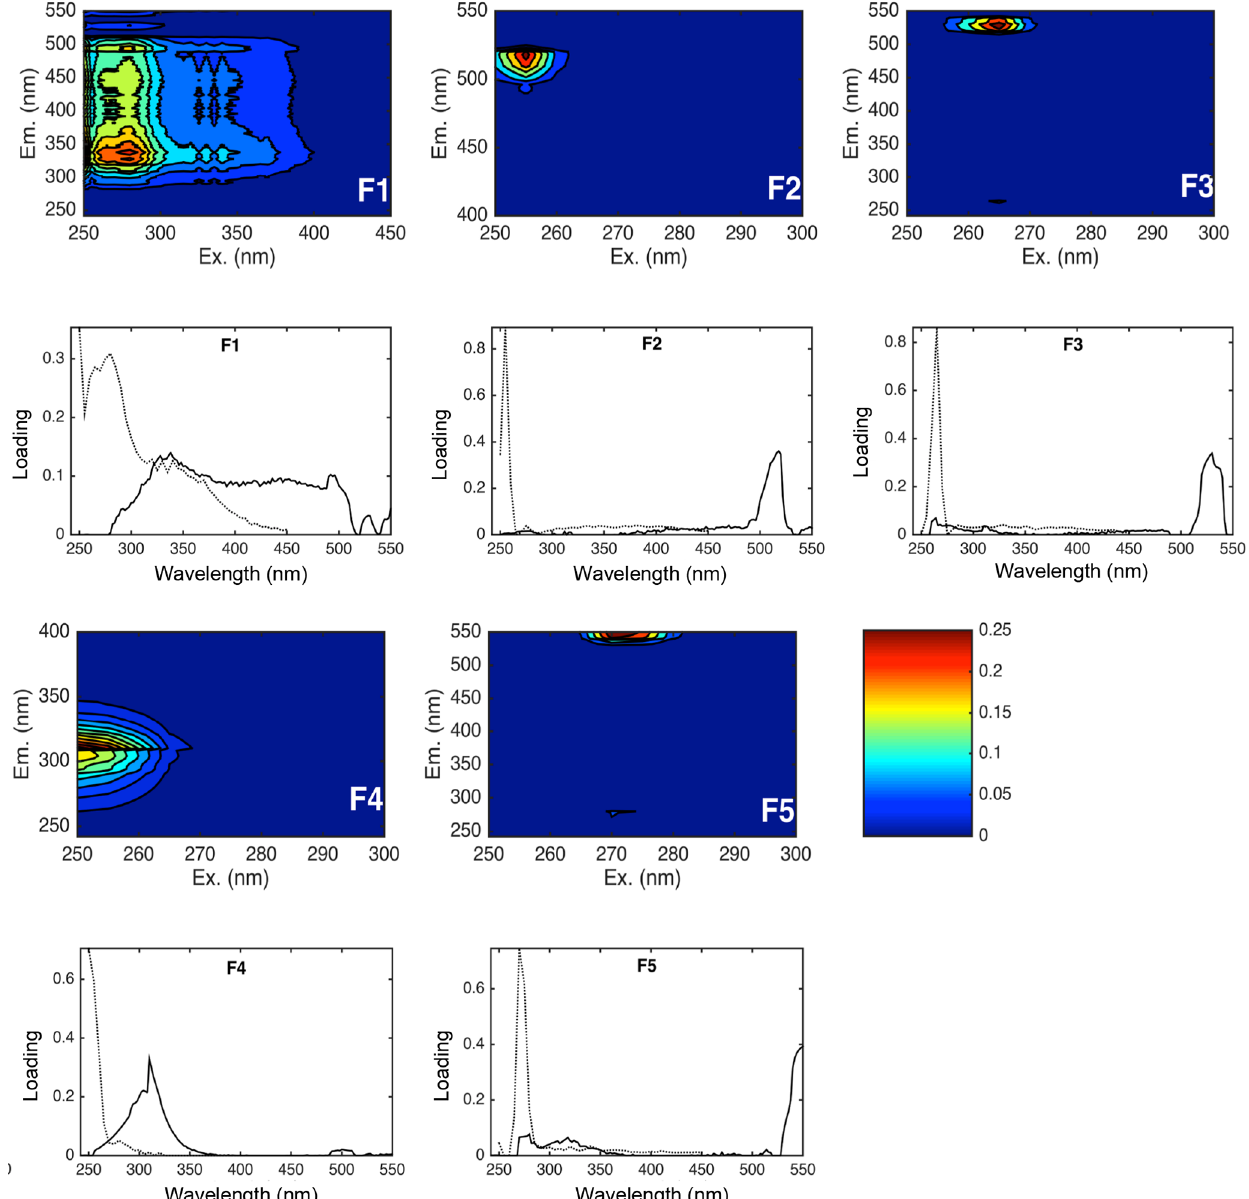
Figure 6. (Above) Contour plots of five fluorescent components as identified by PARAFAC analysis and (below) relative spectral loadings of overlaid spectra for the 5-components model validated with 3 split comparisons. The axes of contour plots have been scaled to better visualize the fluorescence intensities (R.U.). A figure with the complete spectrum is included in the Supplement (Fig. S3). The dashed black line in the spectral loadings indicates excitation maxima for each component, the solid black line indicates emission